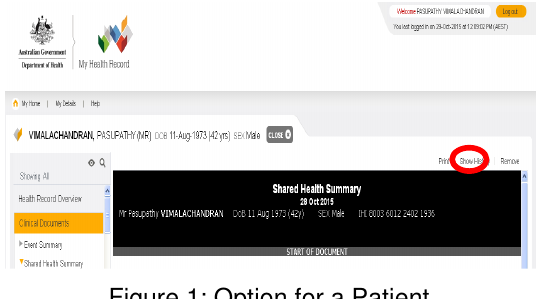
Figure 1: Option for a Patient